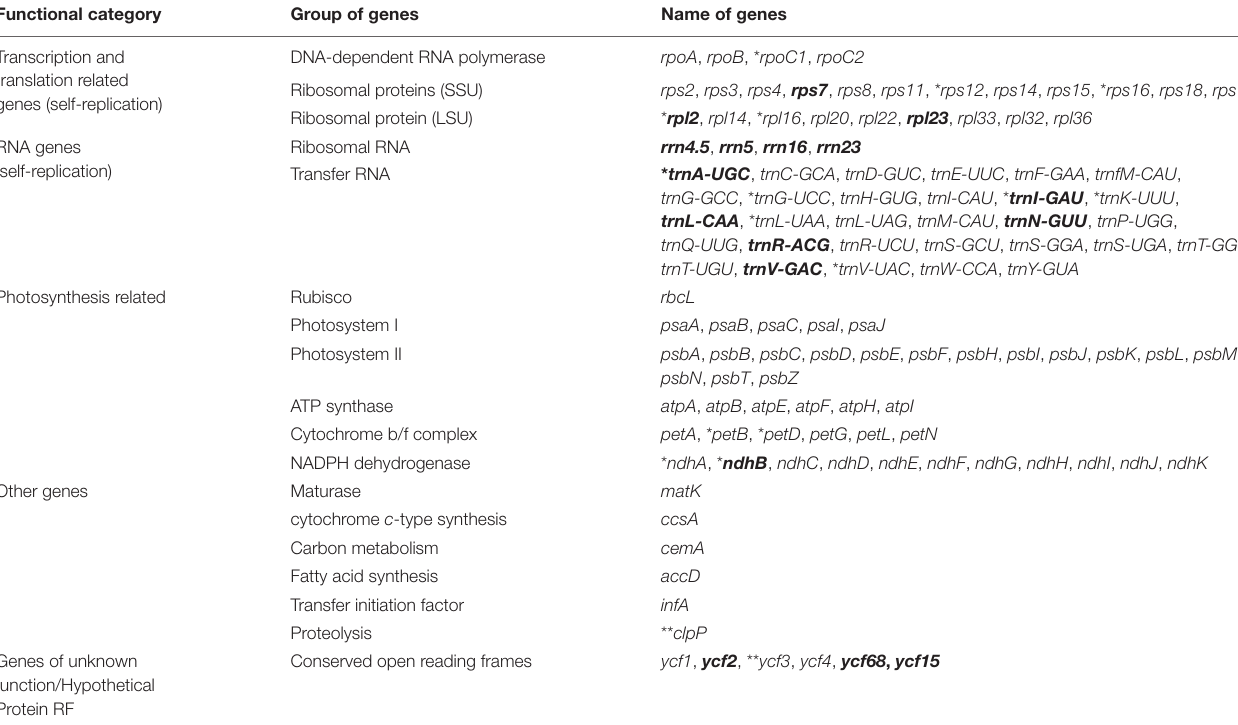
TABLE 2 | Genes present and functional gene category in Alchemilla pedata and Alchemilla argyrophylla chloroplast genome. Functional category Group of